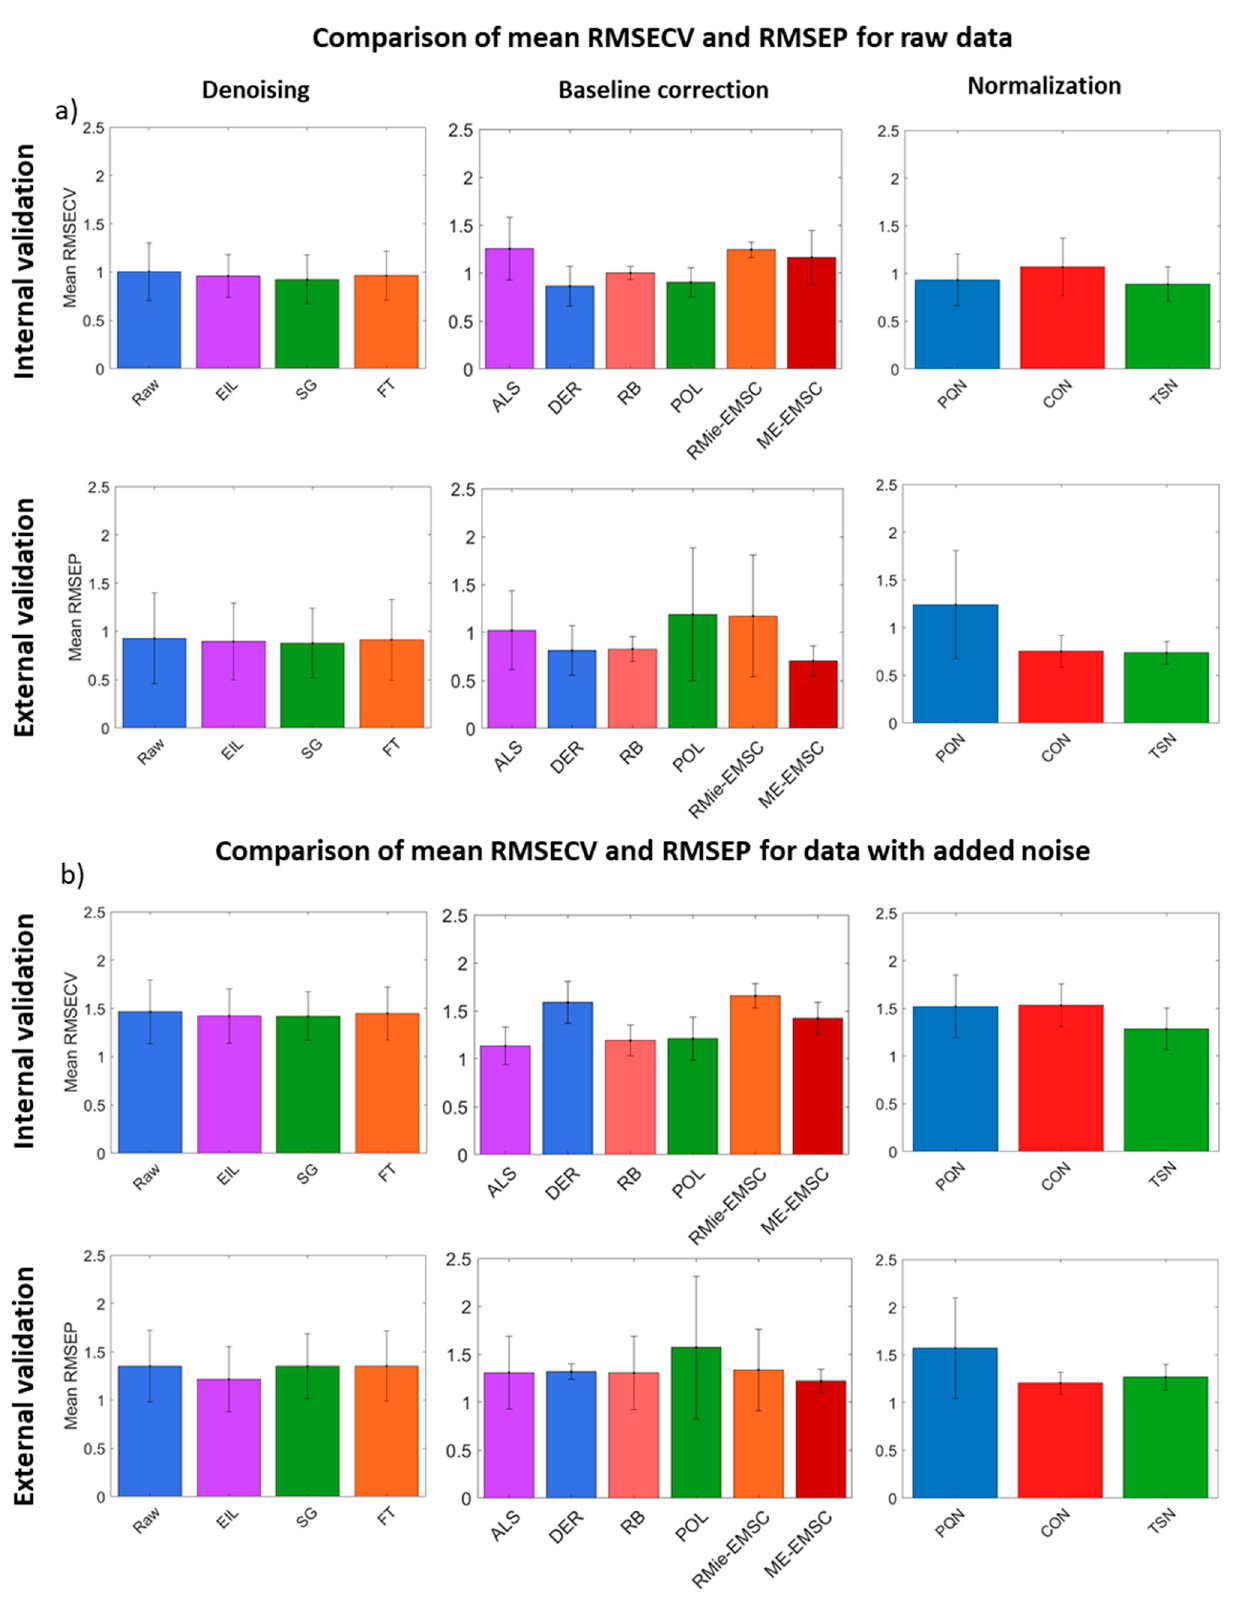
Figure 6. Comparison of PLSR mean RMSECV and RMSEP errors calculated for all methods on each preprocessing step (model with optimal LVs allowed by CV was chosen) for ( a ) original data and ( b ) data with added noise. The standard deviation of all models that used a given method (from the current preprocessing step) in combination with other methods (from other preprocessing steps) was marked with error bars.